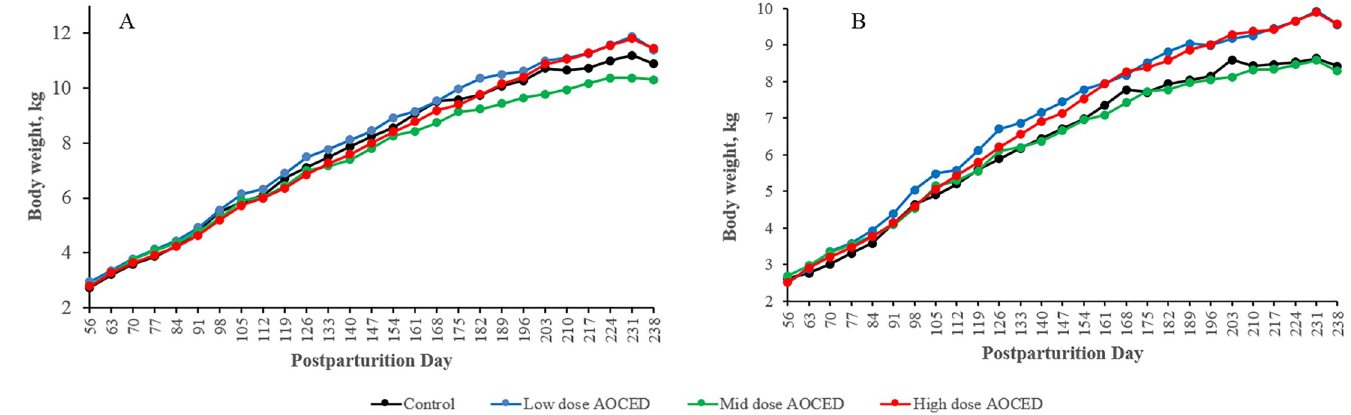
Fig 3. Body weights of puppies (A- males; B—females) after weaning. Values are shown as group means (n = 5).